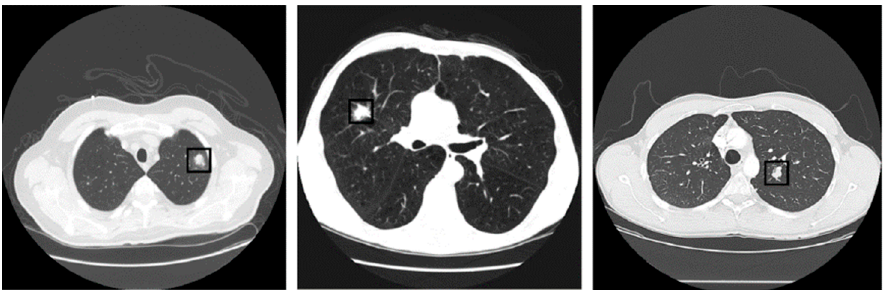
Figure 1. Categories of lung nodules in a CT scan; benign, primary malignant, and metastatic malignant (from left to right).